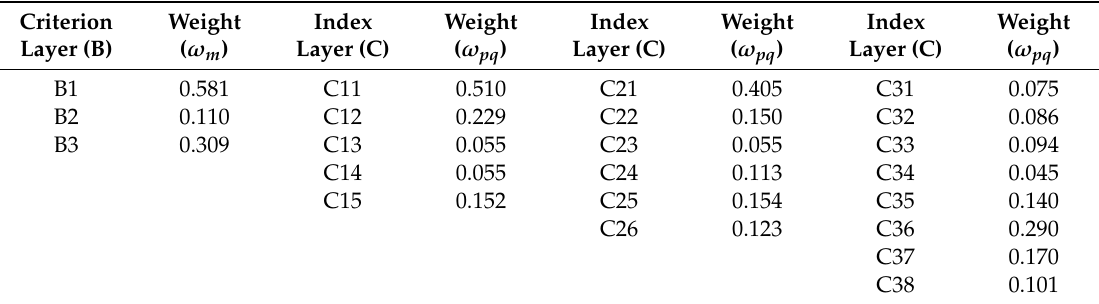
Table 9. The indicator weights for the criterion layer and the index